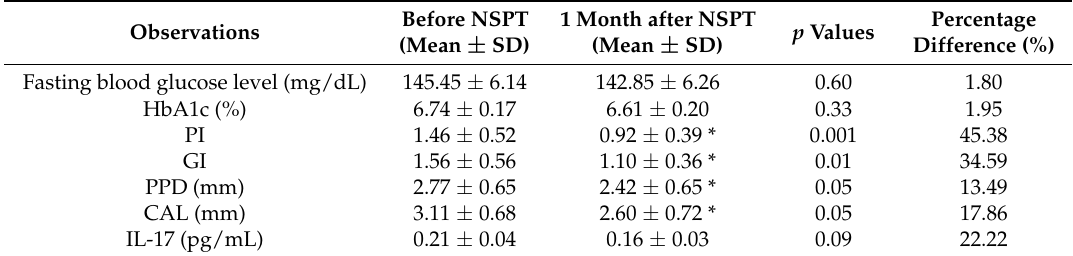
Table 2. Comparison of periodontal and biochemical parameters within the group-II before NSPT and one month after NSPT.